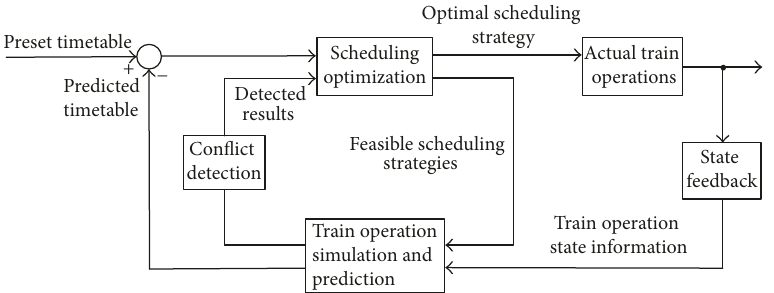
Figure 1: The framework of conflict detection and scheduling optimization of train operations based on model predictive control.